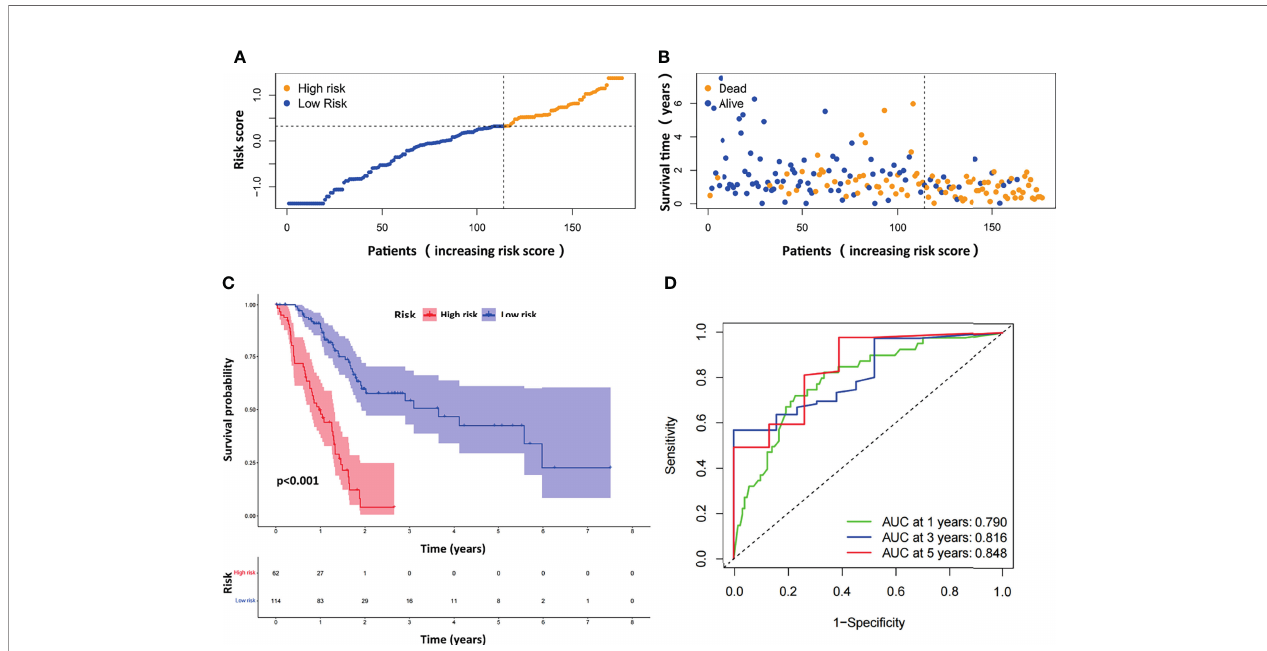
FIGURE 3 | Evaluation of the prognostic ARGPs in the TCGA-PAAD dataset. (A) Distribution of risk scores of high- and low-risk PAAD patients based on the ARGPs-based prognostic signature. (B) The scatter plot showed the correlation between the survival status of high- and low-risk PAAD patients. (C) Kaplan-Meier analysis of the high-risk and low-risk groups of PAAD patients in the TCGA. (D) ROC curves of the risk scores of PAAD patients in the TCGA at 1, 3, and 5 years. AUC, area under the receiver operating characteristic curve.